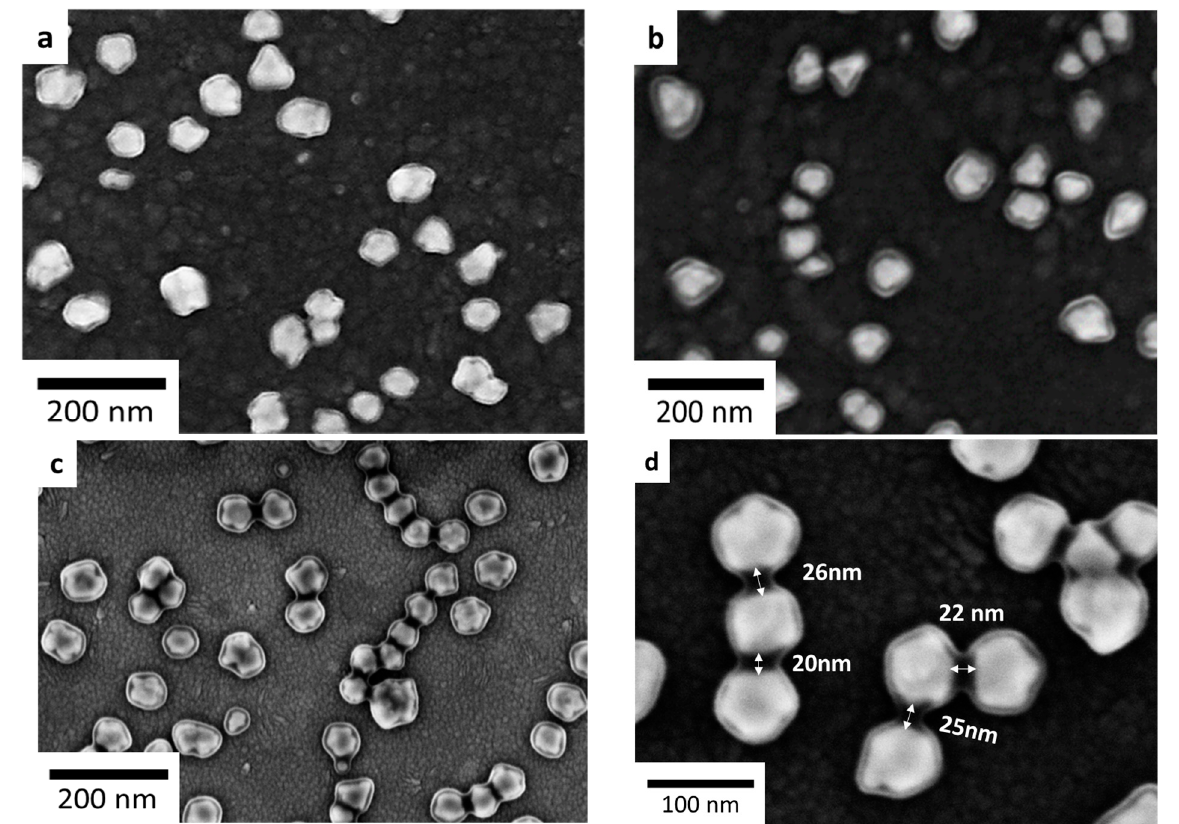
Figure 4. SEM images of AuNP-based plasmonic substrate after ( a ) 15 min of spontaneous grafting in the dark; ( b ) 15 cycles of electrochemical grafting; ( c , d ) 15 min of irradiation by visible light.